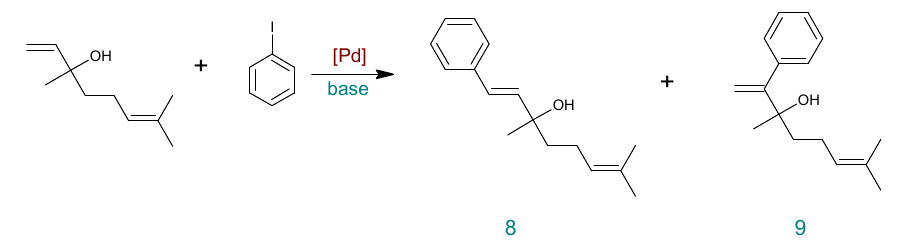
Table 7. Results of the Heck arylation of linalool with